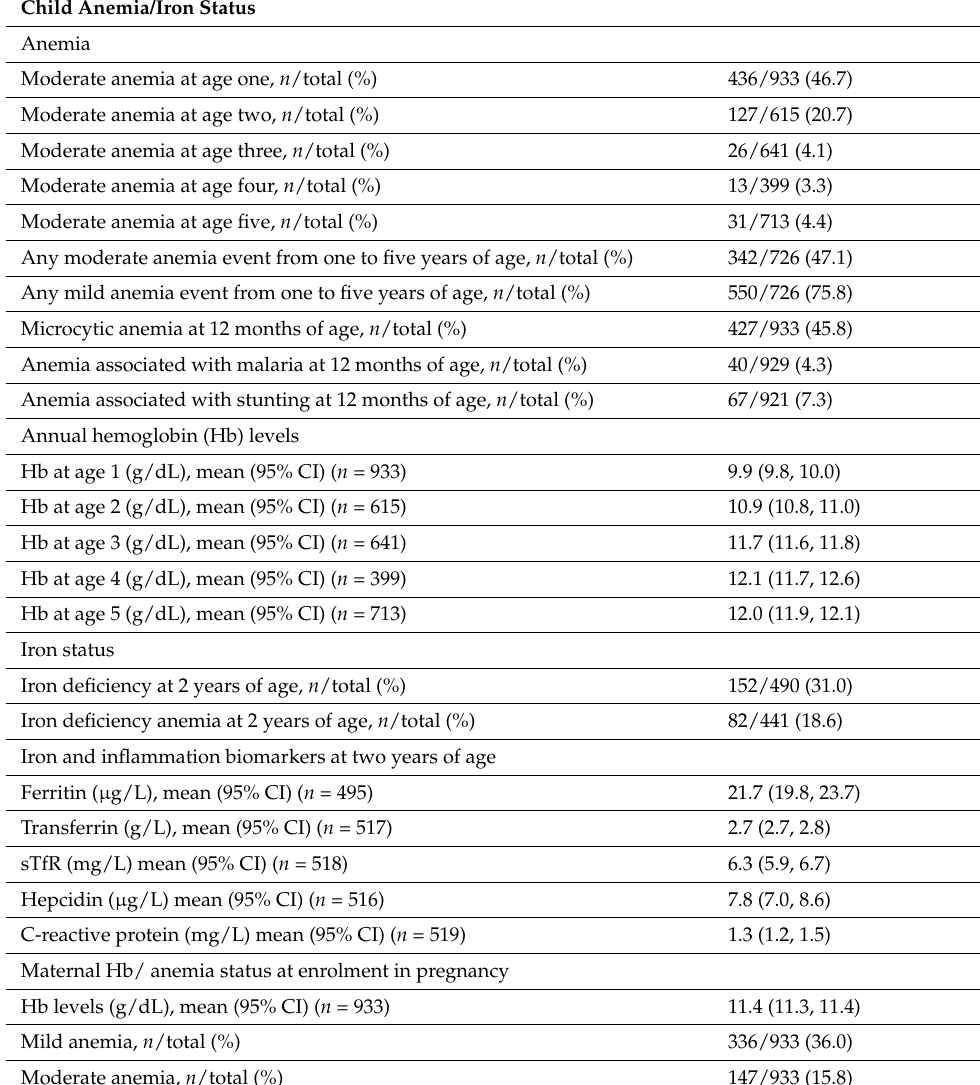
Table 2. Distribution of hemoglobin levels and markers of iron status and